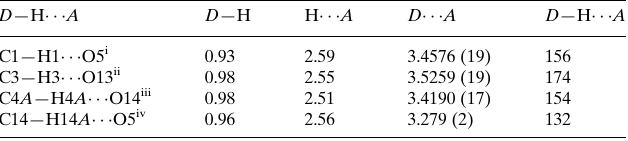
Hydrogen-bond geometry (A˚ , (cid:2)